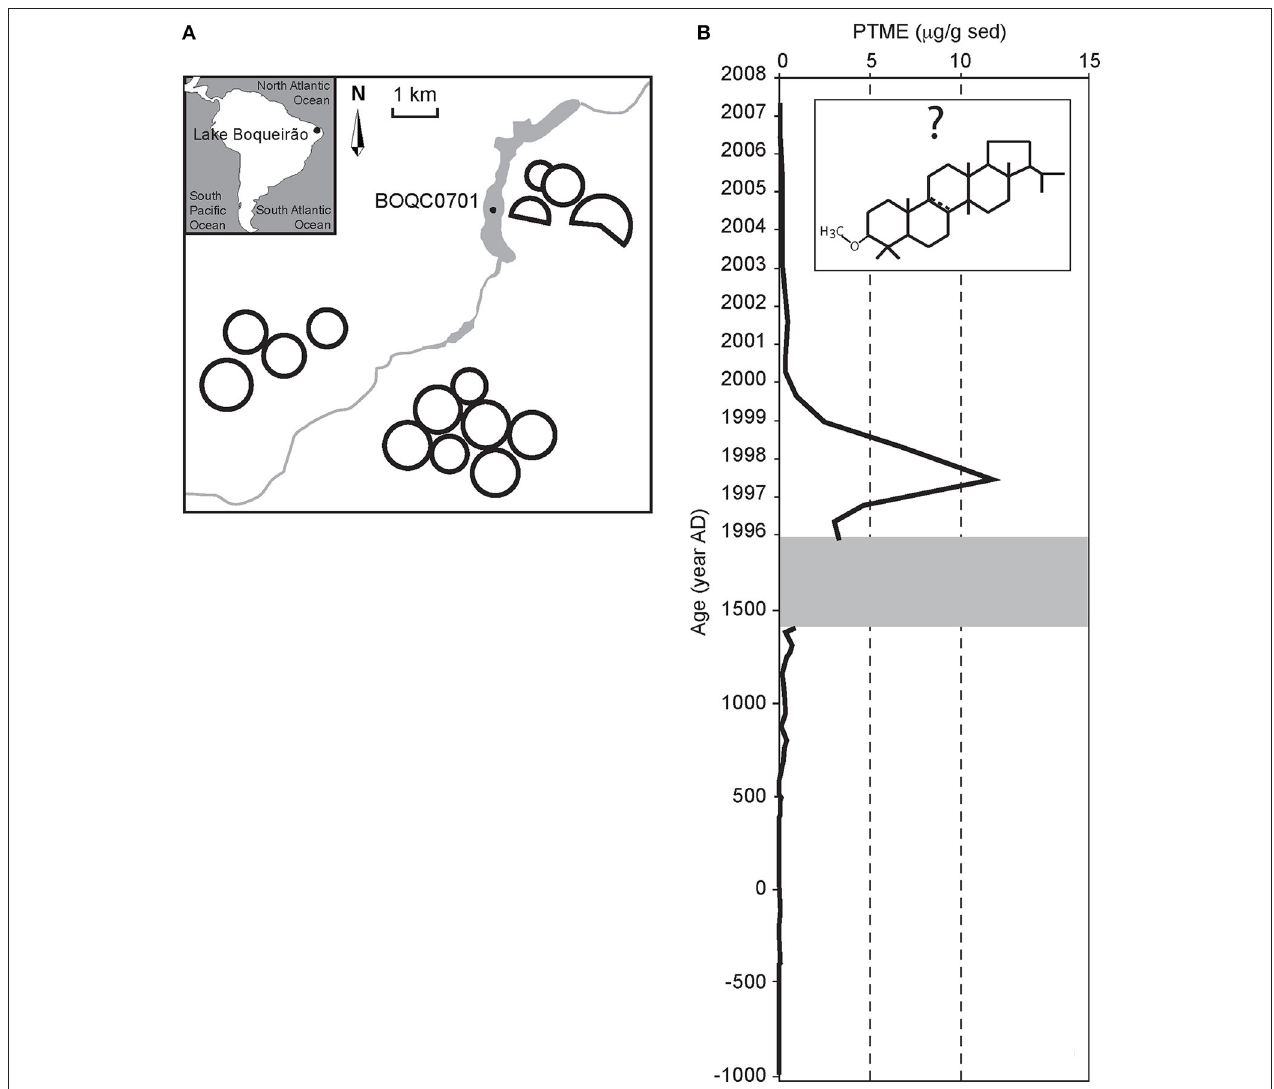
FIGURE 2 | (A) Location of Lake Boqueirão (Northern Brazil) with coring site and sketch of the catchment illustrating irrigation circles. (B) Evolution of a pentacyclic triterpene methyl ether (with proposed structure) in the sediments of Lake Boqueirão attesting the recent installation of turf cultivation in the catchment. Modified from Zocatelli et al.